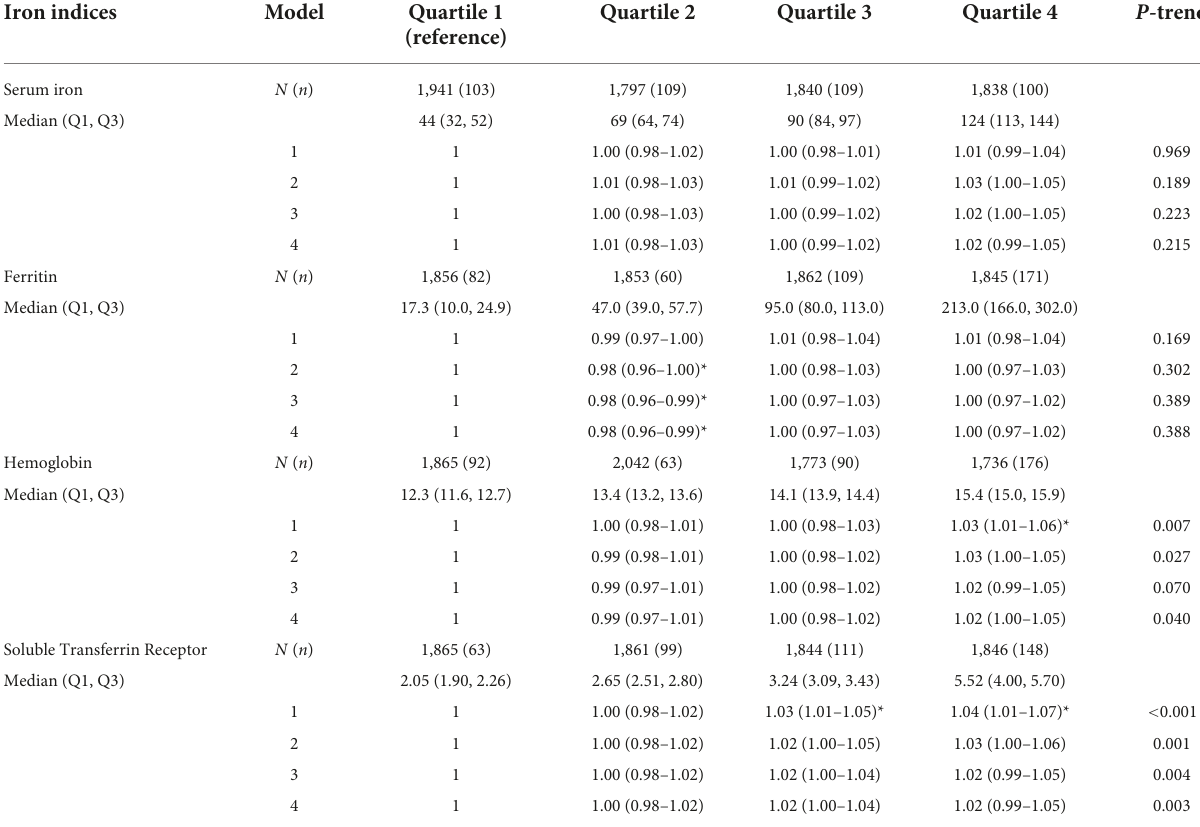
TABLE 4 Association between markers of iron metabolism (as quartile) and diastolic hypertension in National Health and Nutrition Examination Survey (NHANES) 2007–2010 and NHANES